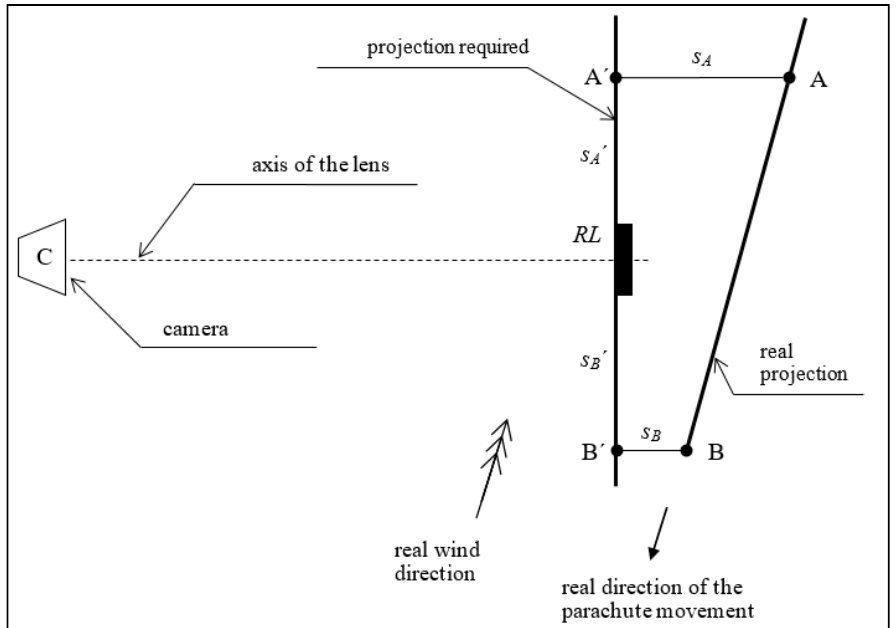
Figure 7. Determining the projection of the actual trajectory of the parachute movement on the earth’s surface—view from above (source: The authors of this article).